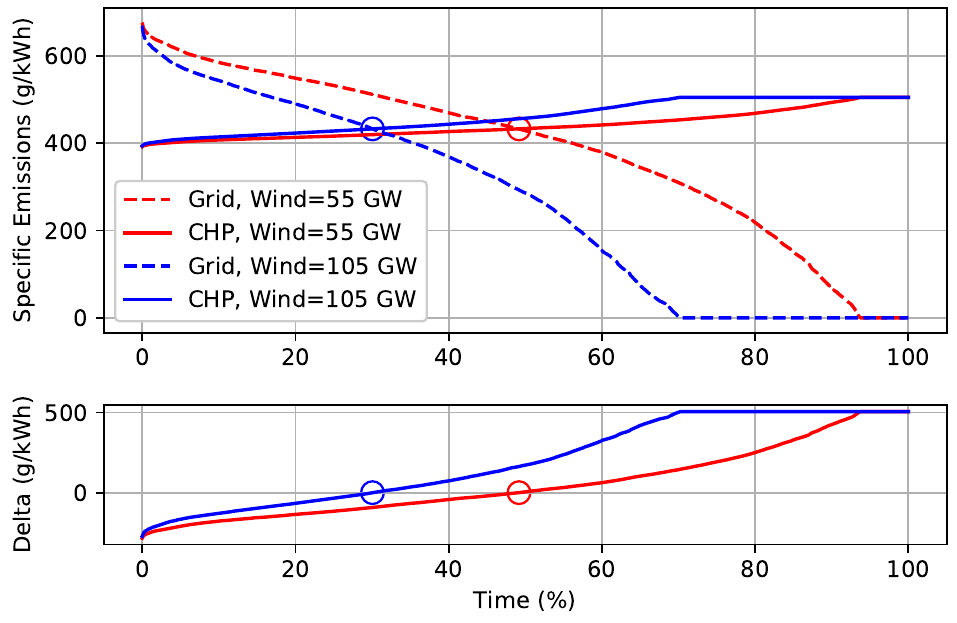
Figure 6. Duration curves (100% corresponds to one year) of the emission factors of electricity from both, CHP and grid, for two scenarios of nation-wide installed wind capacity (upper panel) and difference of the two duration curves (lower panel). Based on data from